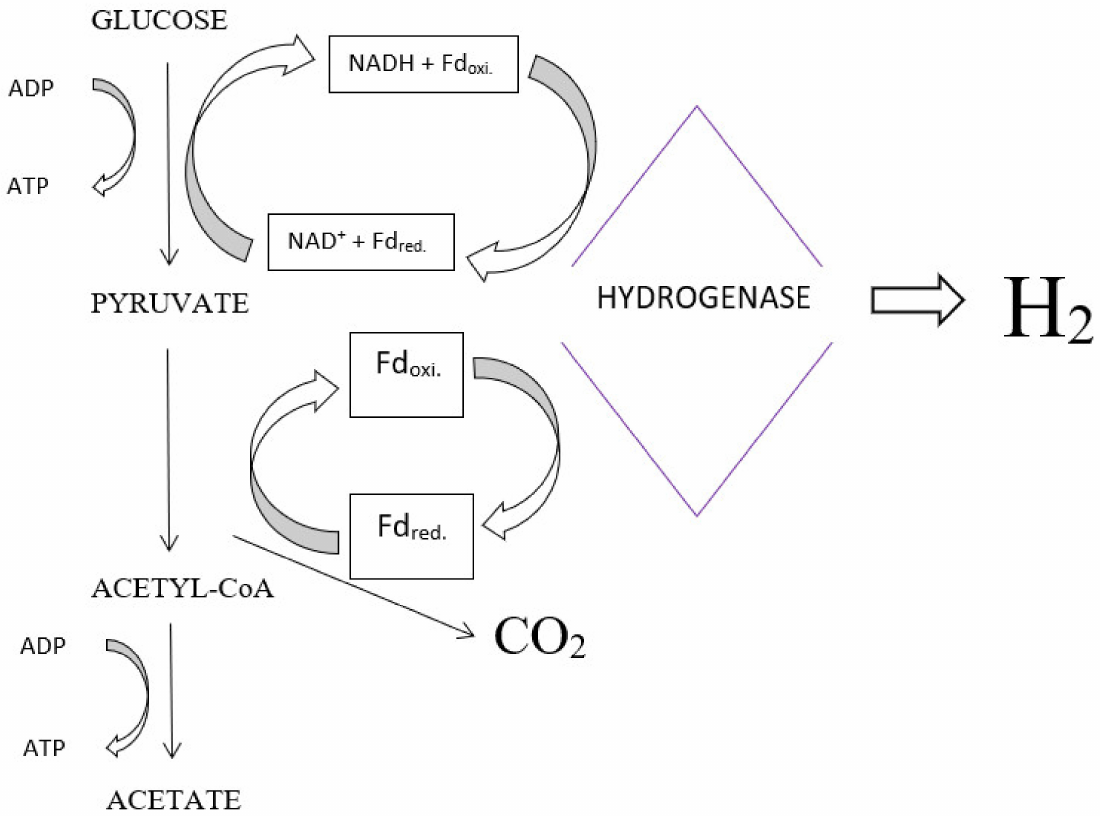
Figure 1. Diagram of hydrogen production by Clostridium